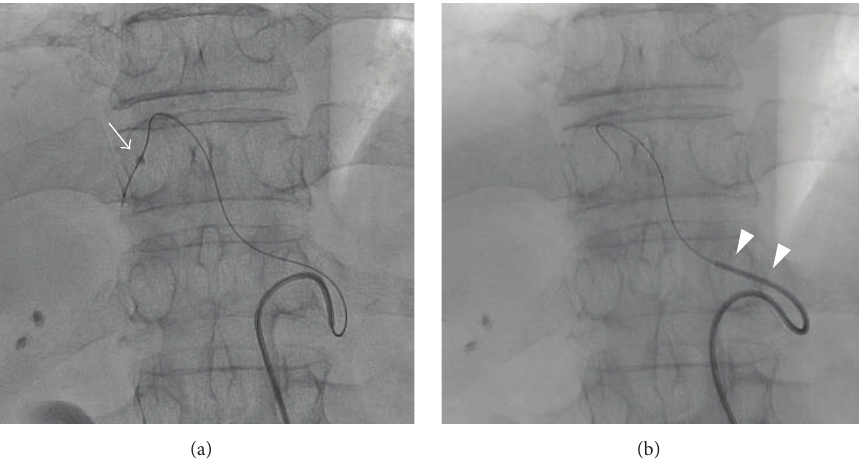
Figure 3: (a) A microballoon catheter was inserted into a branch of the left medial segment and inflated (arrow). (b) The 5 Fr catheter was advanced into the common hepatic artery (arrowheads). In this figure, the microballoon had already been